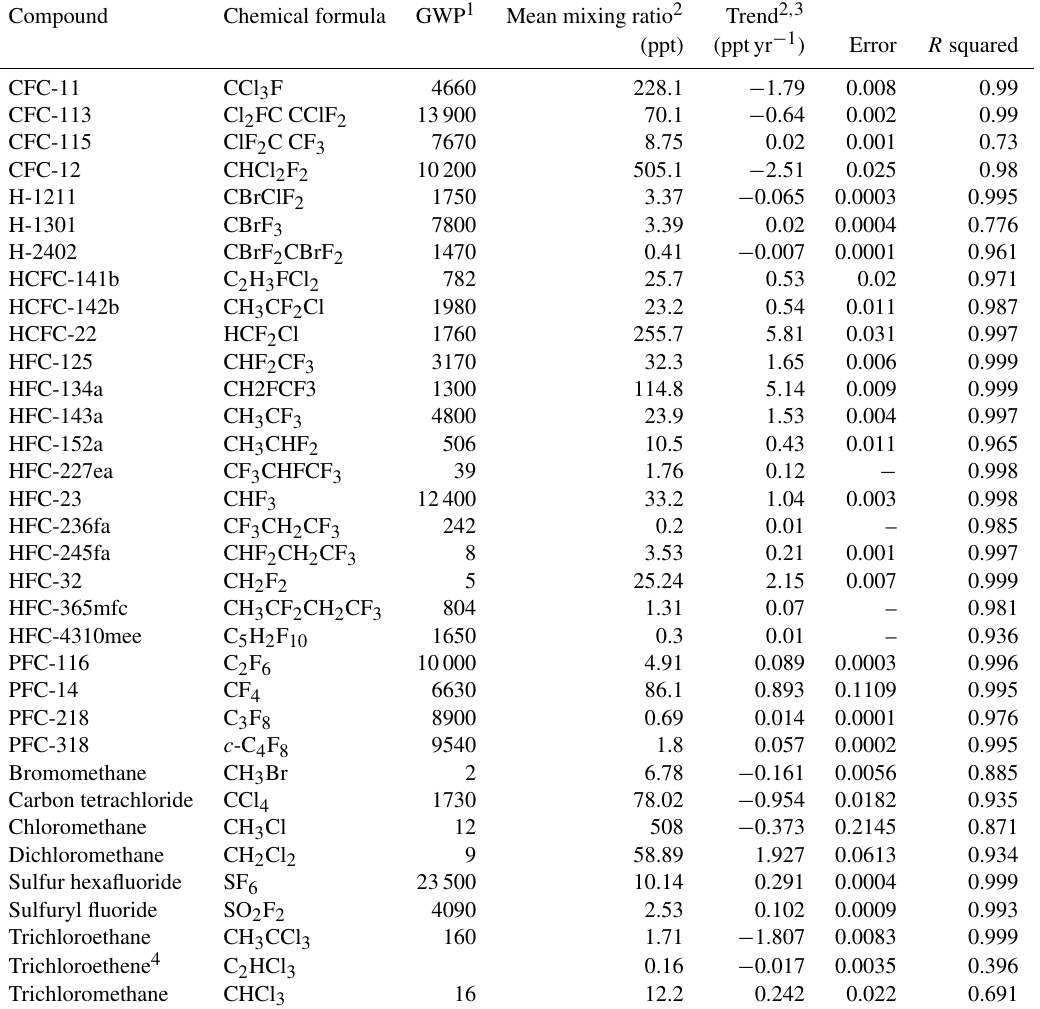
Table 6. Halogenated compounds measured at the Zeppelin Observatory and their chemical formulas, global warming potentials (GWPs, CO 2 = 1), mean mixing ratios in 2019, fitted trends, and trend fit parameters (error and R 2 ). For compounds measured only from 2010 (see also Table 3), the uncertainty in the trend is higher than for compounds measured from